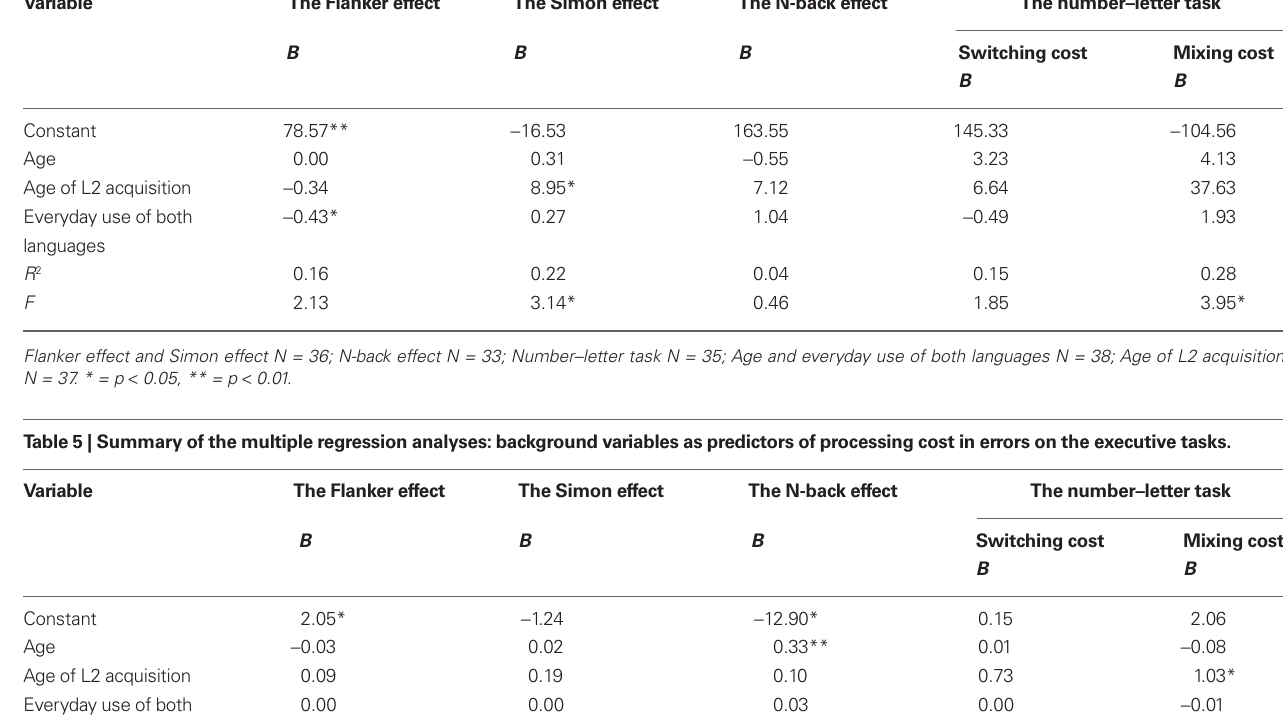
Table 4 | Summary of the multiple regression analyses: background variables as predictors of processing cost in RTs on the executive tasks. Variable